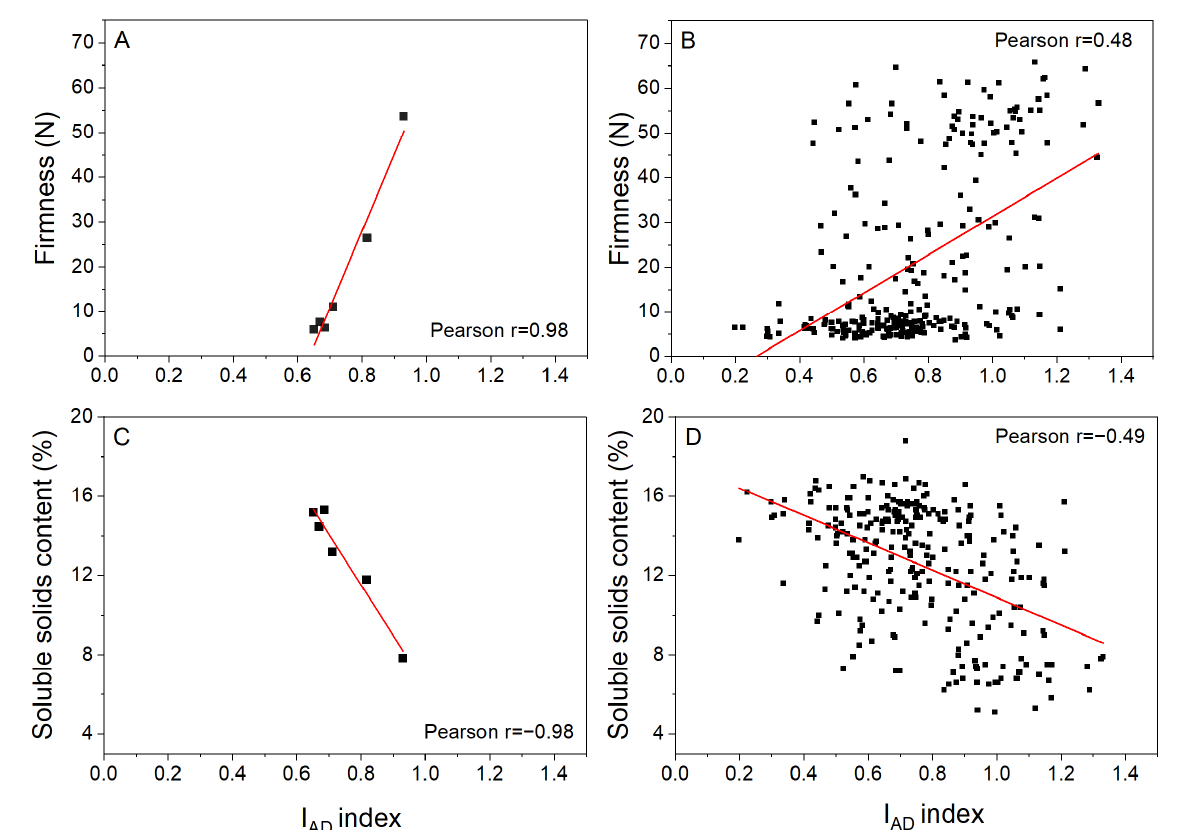
Figure 5. Associations between I AD and fruit firmness ( A , B ) and soluble solids content ( C , D ) for Actinidia chinensis var. chinensis ‘Donghong’ fruit from 3 maturity areas stored for 0, 2, 4, 6, 8, and 12 weeks at 1 °C. Associations are based on sample averages for three maturity areas ( A , C ) and individual fruit ( B , D ) data. At each assessment, 15 fruit were measured per maturity area.